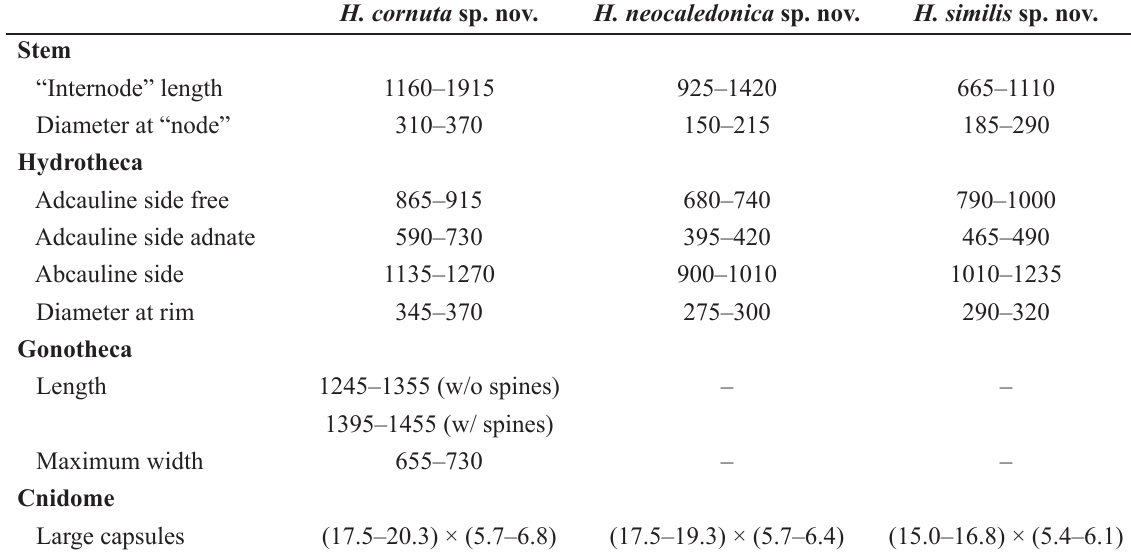
Table 3. Measurements of new species of Hincksella Billard, 1918, in